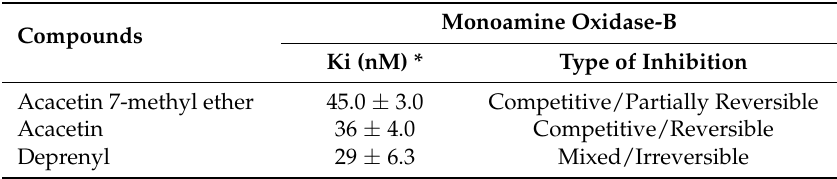
* Values are mean ± S.D. of triplicate experiments.